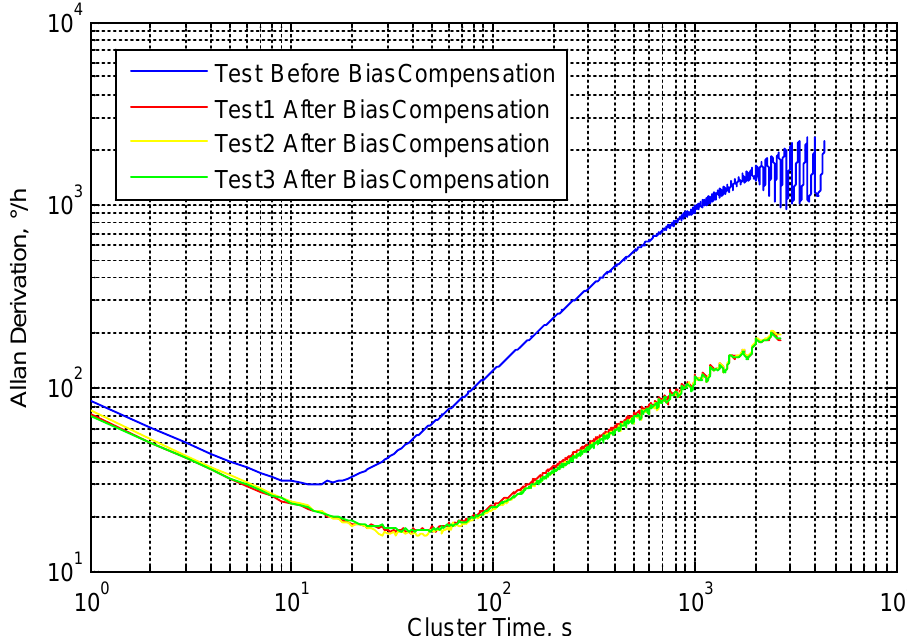
Figure 12. MEMS gyroscope bias before and after temperature compensation. Micromachines 2018 , 9 , x FOR PEER REVIEW